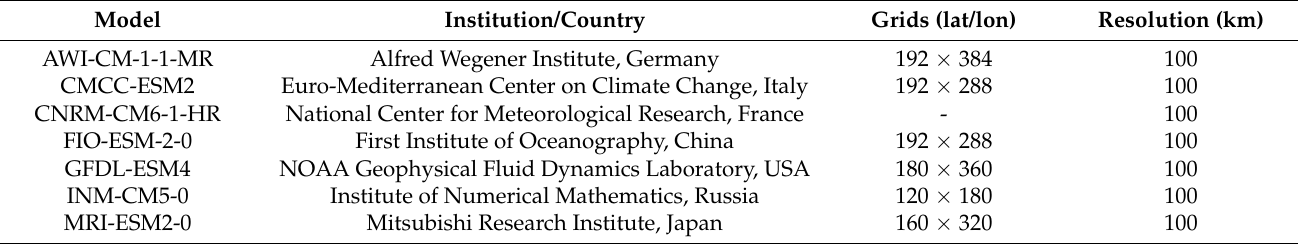
Table 1. Information of seven Coupled Model Intercomparison Project (CMIP6) models.